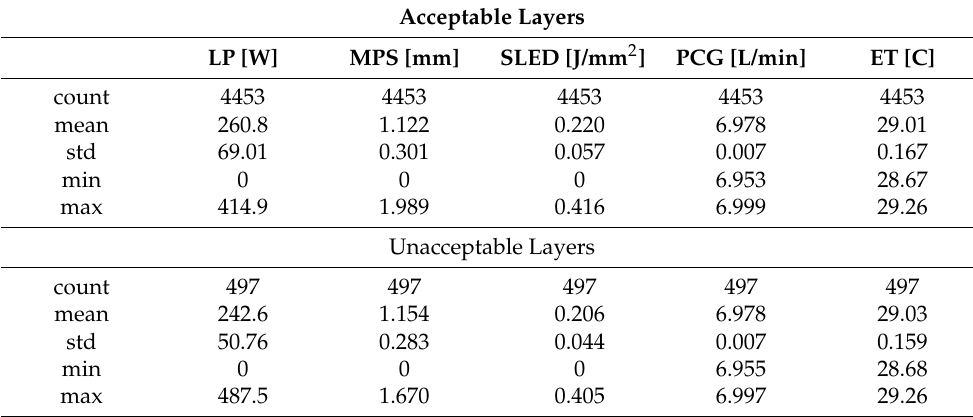
Table 5. Comparison of features based on layer quality.